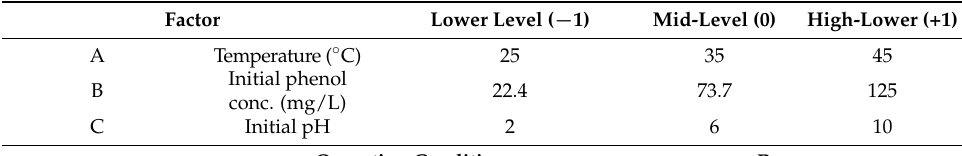
Table 1. FC-CCD RSM experimental design matrix and results for phenol uptake onto Na-SBAC-